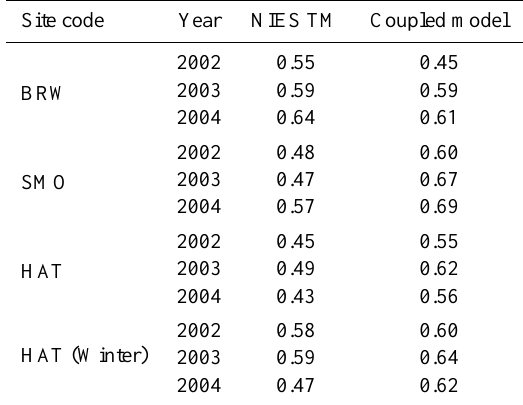
Table 1. Correlation coefficients between simulated and observed deseasonalized CO 2 concentrations (Winter: from the beginning of January to the end of March, and from the beginning of November to the end of